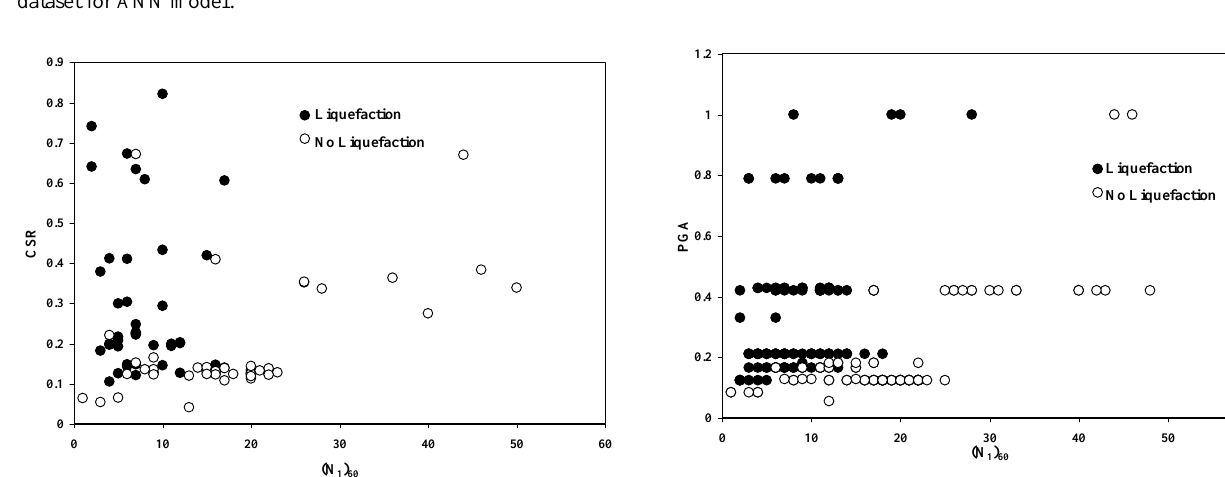
Figure 5. Plot between CSR and (N 1 ) 60 for MODEL I using testing dataset for BP model.